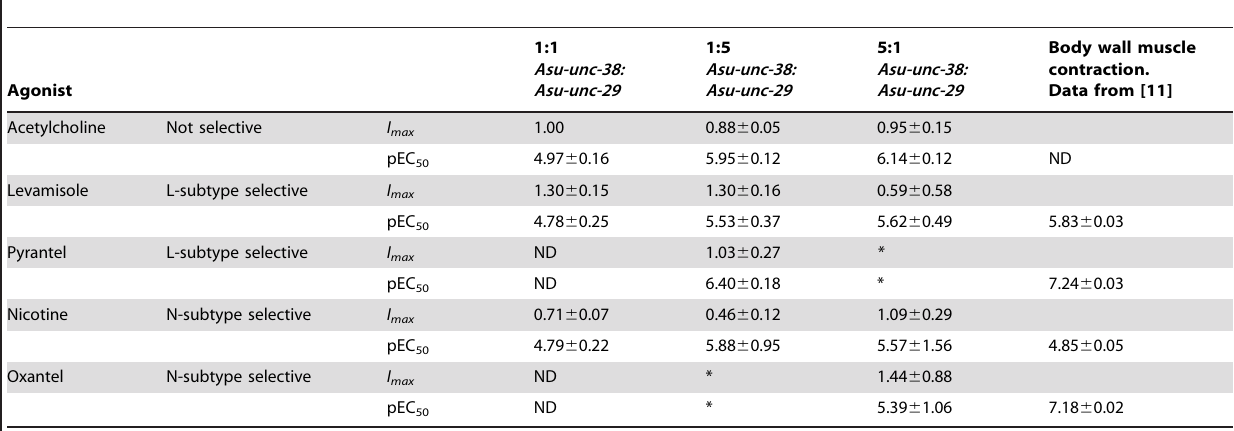
Table 2. Summary of the properties of the receptors formed after injection of Asu-unc-38 and Asu-unc-29 cRNAs at different ratios.